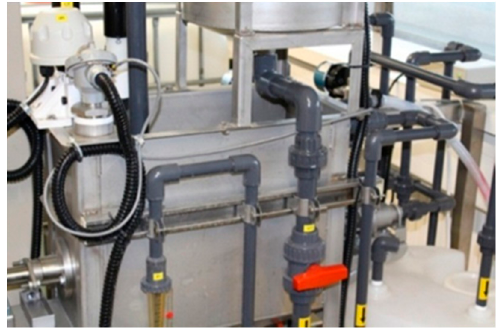
Figure 2. Rotating membrane bioreactor (MBR) system RPU-185 in operation. The membrane module is located in the batch tank for filtration purposes.